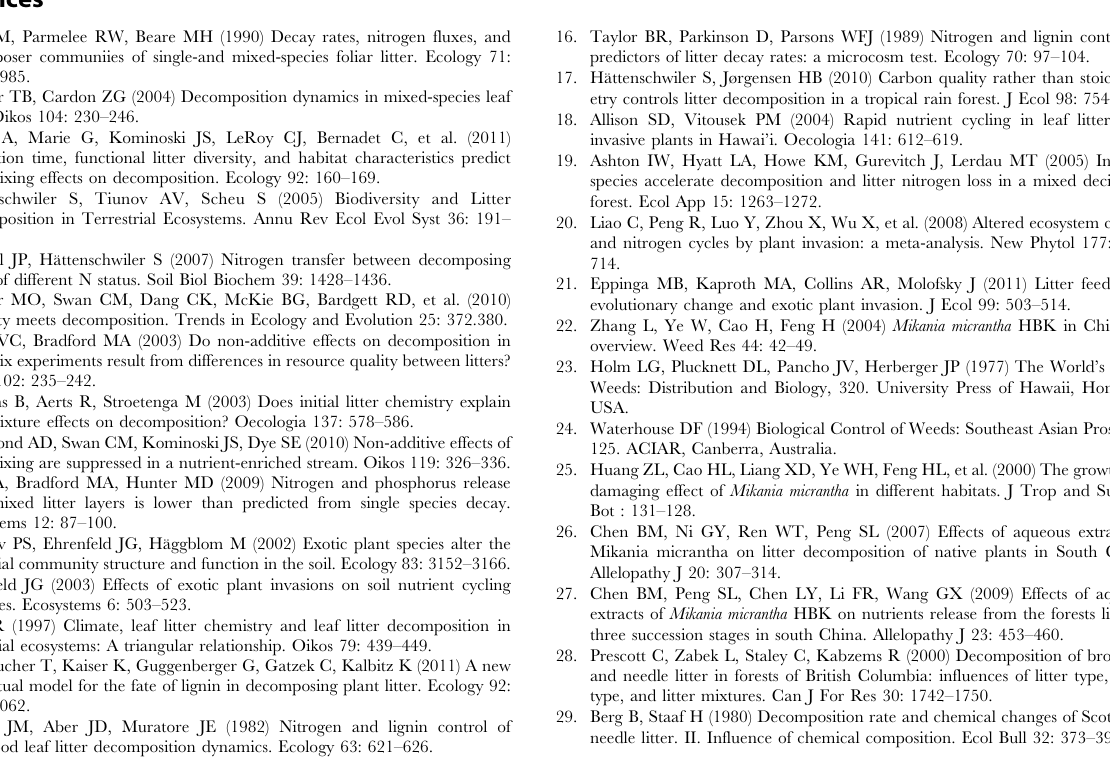
Table S2 Pearson coefficients between mixing effect of litter mass loss, N, C release with the difference in initial single litter N content and C/N ratio. Table S3 Overall results of mixing effect on litter mass loss, N release and C release between litter mixing types, between mixing ratios, between decay time. Table S4 Observed litter mass loss. Table S5 Observed litter N release. Table S6 Observed litter C